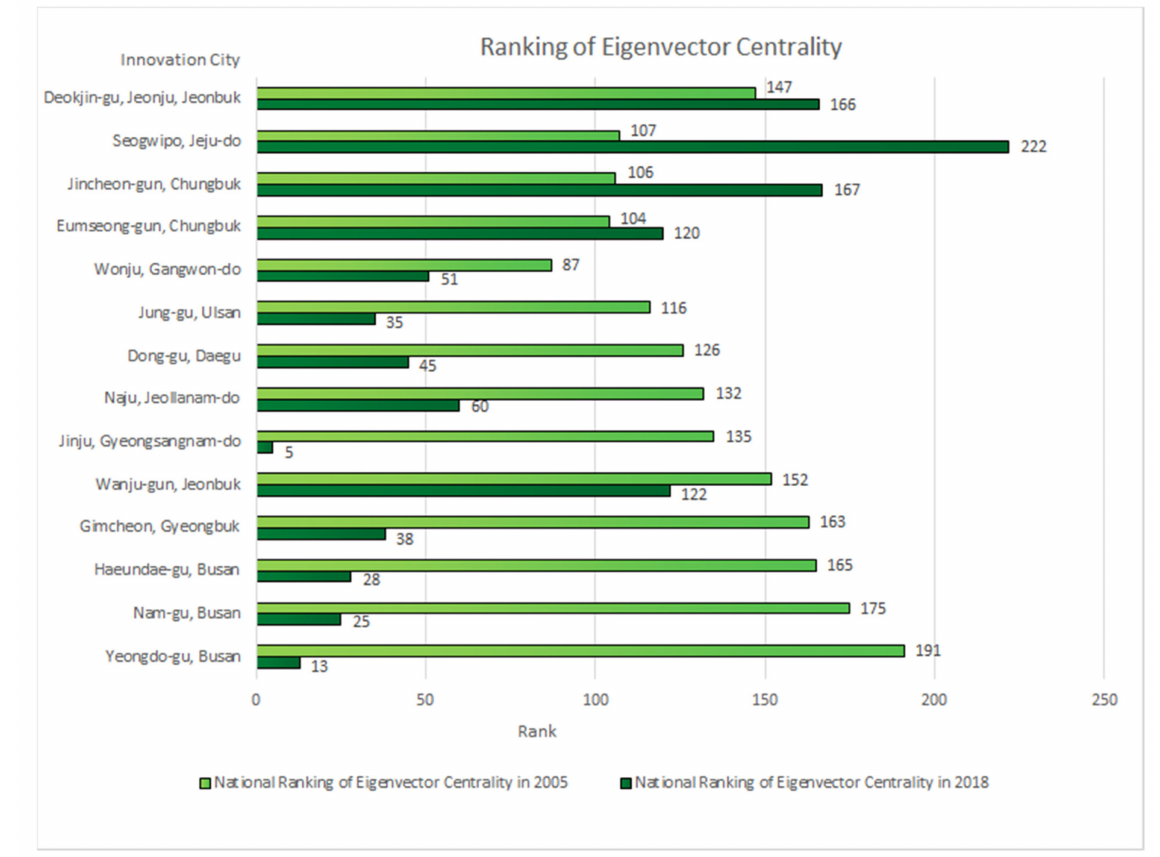
Figure 5. Changes in the eigenvector centrality rankings of Innovation